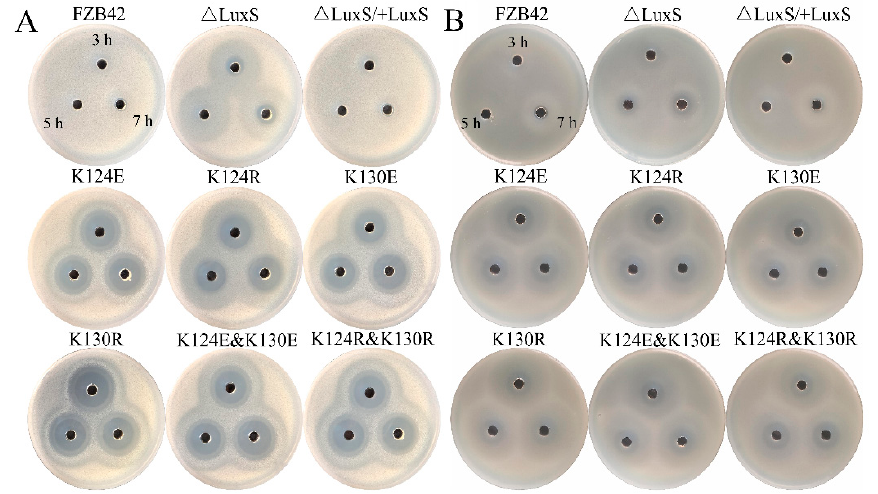
Figure 6. Antagonistic activities of FZB42 WT and its derived mutants against the indicator strains B. megaterium ( A ) and S. aureus ATCC 9144 ( B ). The cell-free supernatants of the strains prepared from the 3rd, 5th, and 7th hour were filled into the holes. Inhibition zones were examined after overnight incubation.